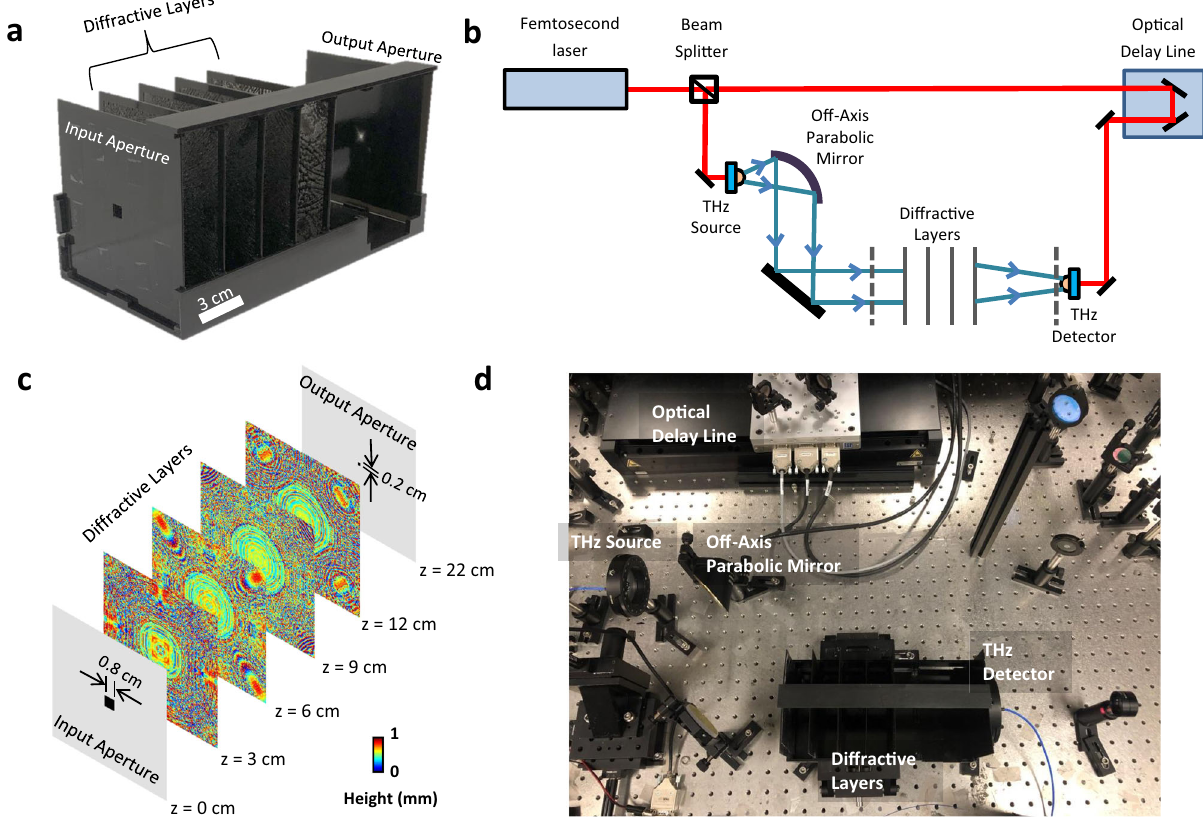
Fig. 1 Schematic of the pulse shaping diffractive network and a photo of the experimental setup. a 3D printed pulse shaping diffractive network that generates a square pulse with a width of 15.57 ps. b The schematic of the THz-TDS setup used in our experiments. The red line represents the optical path of a 780 nm femtosecond laser, and the blue line represents the terahertz beam. Dashed lines show the input and output apertures of the diffractive network. c The physical system layout of the pulse shaping diffractive network design. The input and output apertures are squares, with edge lengths of 0.8 cm and 0.2 cm, respectively. Gray regions on the aperture planes represent aluminum coating to block light transmission. d The photo of the experimental (depicted by the red arrows in Fig. 2b). The numerically predicted output waveform (blue) in Fig. 2c indicates that a 4-layer diffractive network can synthesize a square temporal waveform with a pulse width of 15.69 ps without using any conventional optical components, in a compact architecture that spans approximately 250-times the carrier wavelength in the axial direction. The pulse width of the temporal waveform created by the 3D printed diffractive layers at the output aperture is measured as 15.52 ps, closely matching the numerically predicted result (15.69 ps). Similarly, a comparison of the output spectral amplitude pro fi les for the numerical and experimental results shows a good agreement in terms of the peak locations of the main and side lobes, as well as the relative amplitude carried by each spectral component. On the other hand, an examination of the unwrapped phase pro fi les (experimental vs. numerical) reveals that the 3D-fabricated, physical diffractive network could not exactly create the sharp phase transitions at the expected spectral locations, but rather generated smoothened transitions.